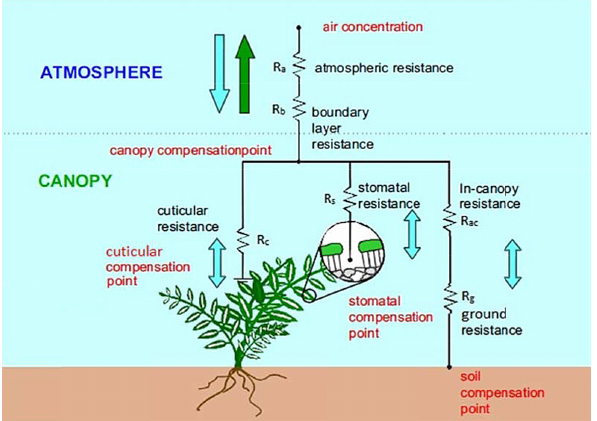
Figure 1. Resistance scheme implemented in the air–surface exchange model following Sutton et al. (2007) and Zhang et al.